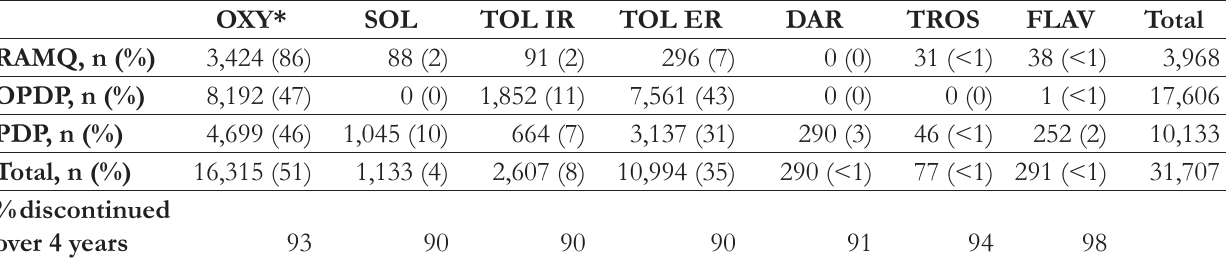
Table 1. Number of Patients by First OAB Medication and Insurance Plan, and Percentage Discontinuation over 4 Years (excluding patients with missing data for age or gender, n=47)